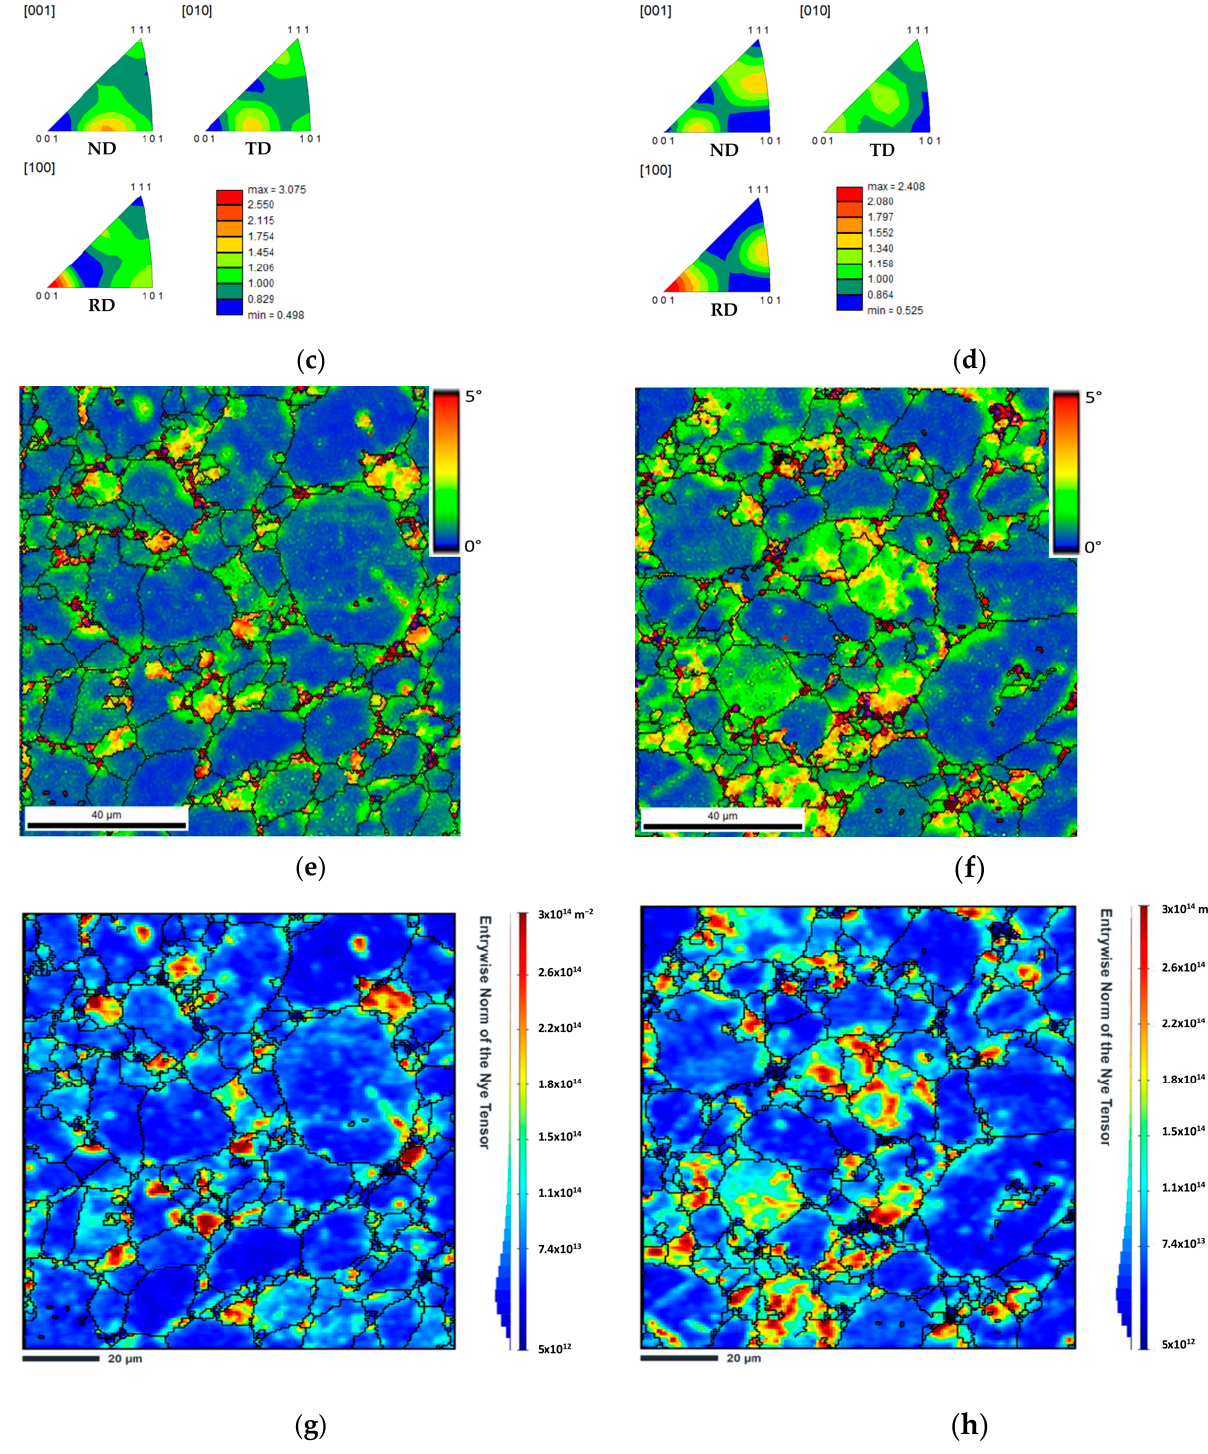
Figure 15. ( a , b ) IPF maps, with high-angle (black) and low-angle (red) boundaries, ( c , d ) IPFs, ( e , f ) GNDs density and ( g , h ) Al and Al/CNT samples at the head of the tensile samples.